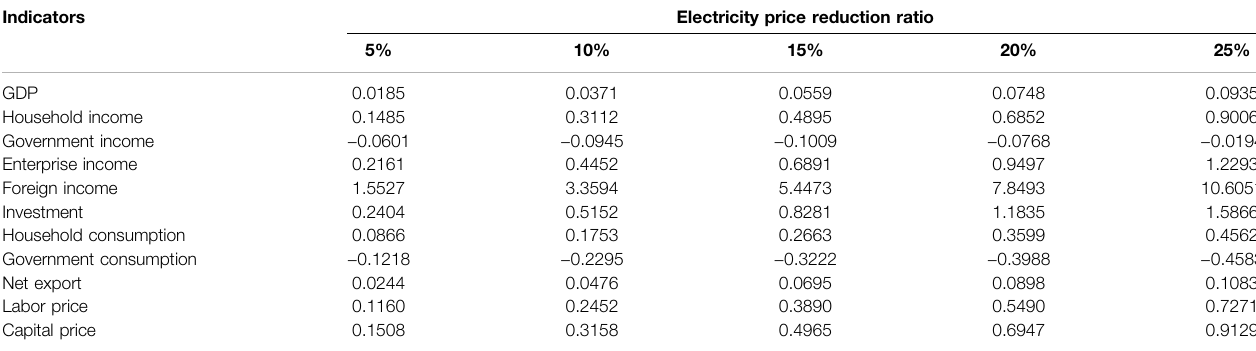
TABLE 2 | Impact of general industrial and commercial electricity price reduction on macroeconomy